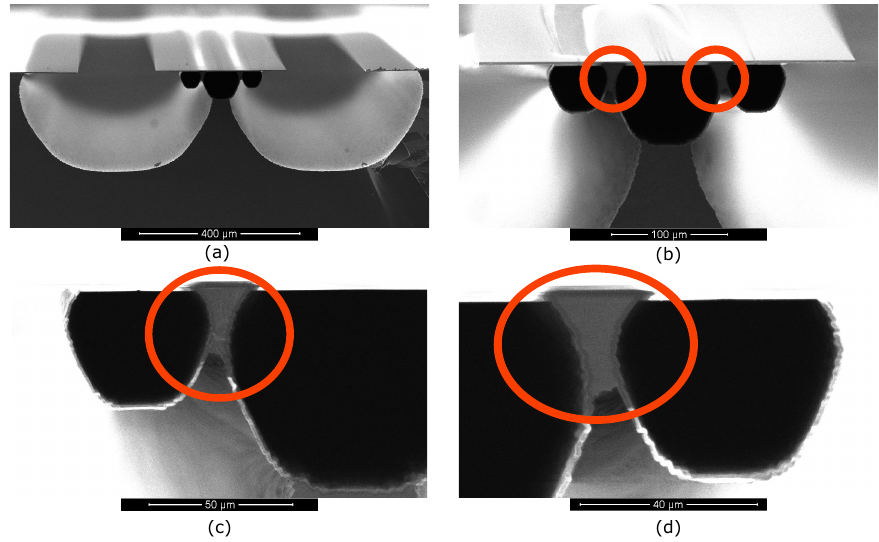
Figure 6. SEM photographs showing the cross-sectional views of fabricated test structures using three microchannels with the small-big-small channel configuration. The produced silicon electrodes are highlighted in the red circles.